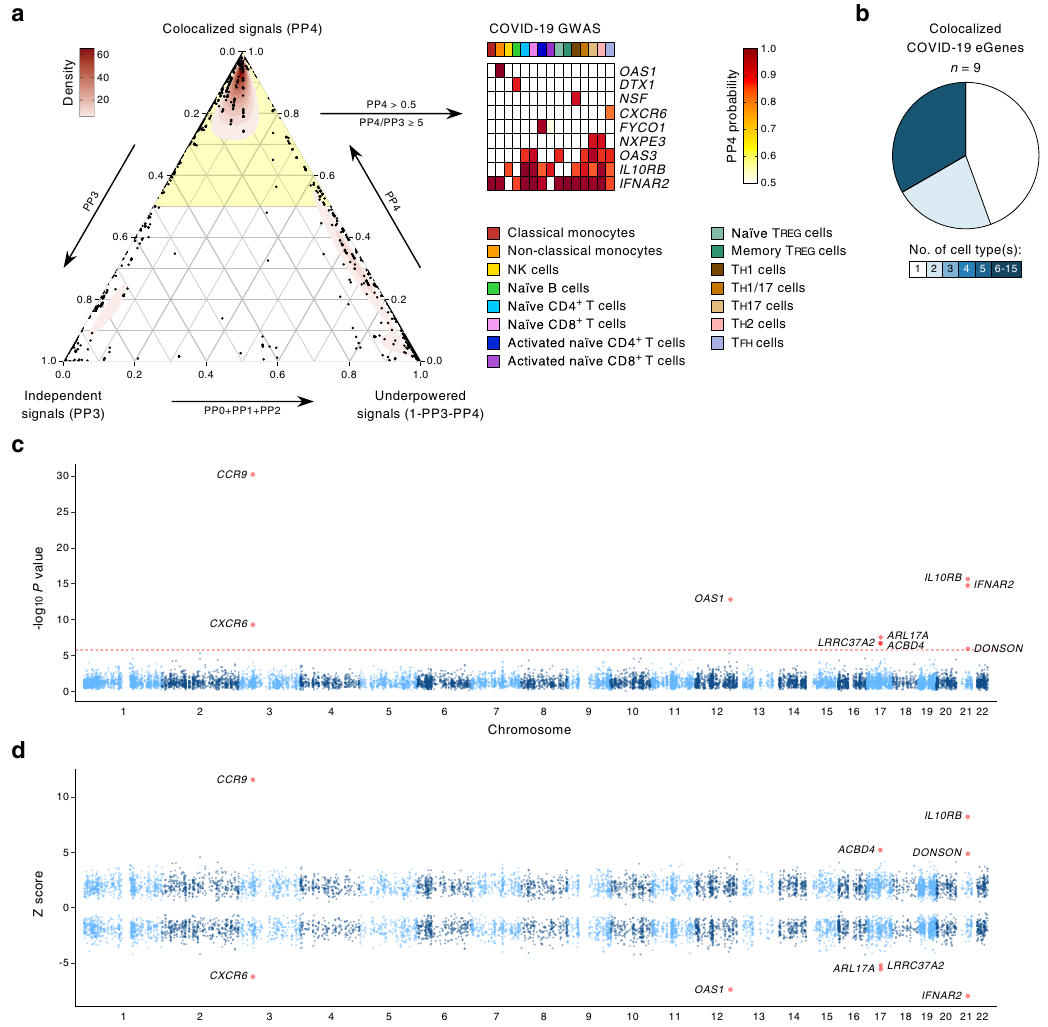
Fig. 1 Prioritization of genes and immune cell types linked to COVID-19-risk variants. a Colocalization analysis. Left panel, a ternary plot showing the posterior probabilities of various con fi gurations from COLOC analysis for each gene – cell-type pairs (PP0 = variant with no association, PP1 = variant with association only with COVID-19 phenotype, PP2 = variant with association only with gene expression (PP0 + PP1 + PP2 = underpowered signals), PP3 = independent association of variants with COVID-19 phenotype and gene expression, PP4 = colocalized variant, where a single causal SNPs is associated with both COVID-19 phenotype and gene expression; see “ Methods ” ). Genes with a high probability of colocalized signals (PP4 > 0.5 and PP4/ PP3 ratio ≥ 5, highlighted in the yellow shade and shown in the right panel) in a speci fi c immune cell type represent putative causal genes linked to COVID- 19 risk. Right panel, genes, and immune cell types in fl uenced by variants associated with COVID-19 phenotypes (combined results of all three COVID-19 phenotypes from GWAS meta-analyses; see “ Methods ” ). For eGenes with colocalized signals (rows), the posterior probabilities of colocalized GWAS and eQTL signals (PP4) is shown for different immune cell types (columns). b Fractions of COVID-19-risk eGenes with colocalized signals identi fi ed in varying numbers of immune cell types. c Single-tissue TWAS (S-PrediXcan 17 ): gene-level Manhattan plot showing the association P value ( − log 10 ) for gene expression with COVID-19 phenotypes; results from single tissue TWAS analysis across tissues is shown (see Methods). The red horizontal line shows gene-level Bonferroni corrected genome-wide signi fi cant P value threshold ( P < 1.613 × 10 − 6 ). d Z scores showing the direction of effect for the genotype- inferred expression of transcripts that encode protein-coding genes in human immune cell types. Red circles indicate genes with Bonferroni corrected genome-wide signi fi cant P value threshold ( P < 1.613 × 10 − 6